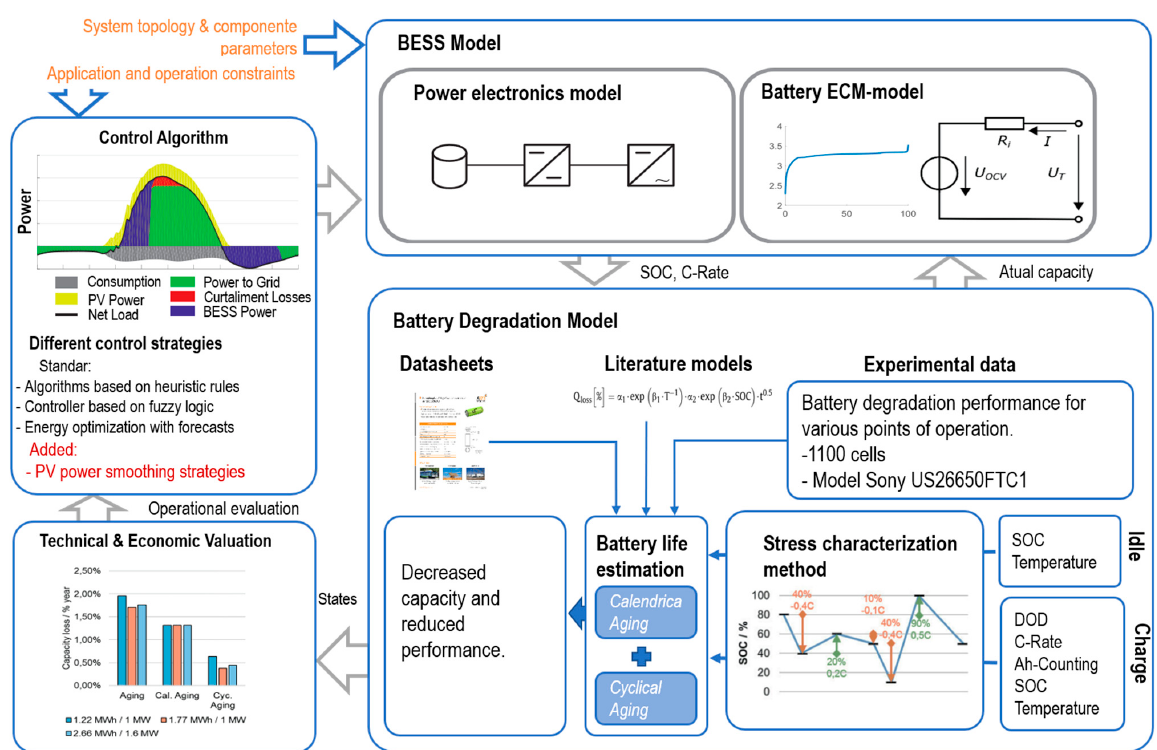
Figure 4. SimSES structure and function blocks (adapted from [29]).